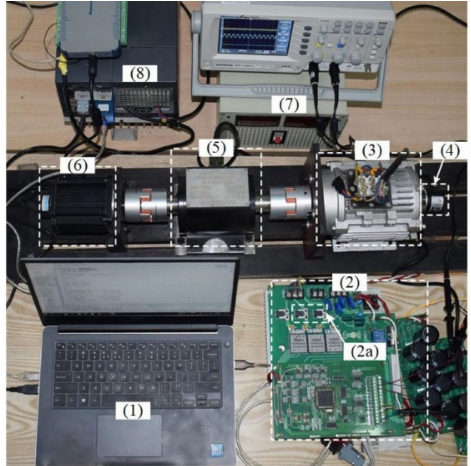
Figure 13. Experimental platform. (1) Computer; (2) Driver board; (2a) Current sensor; (3) IPMSM; (4) Encoder; (5) Torque sensor; (6) Servomotor; (7) Power source; (8) Servomotor